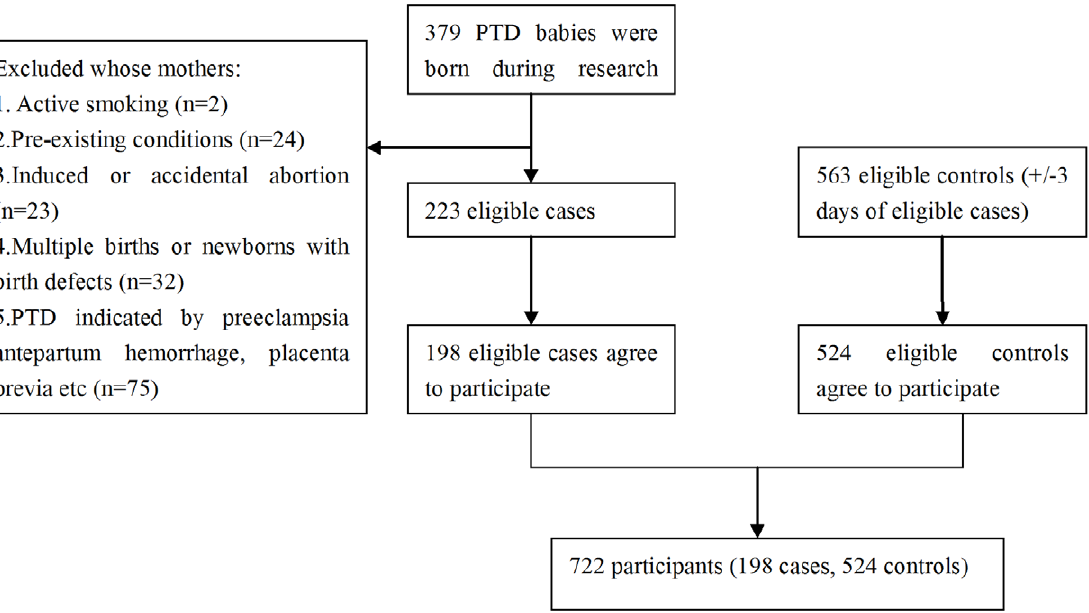
Figure 1. Flow chart of study participants.